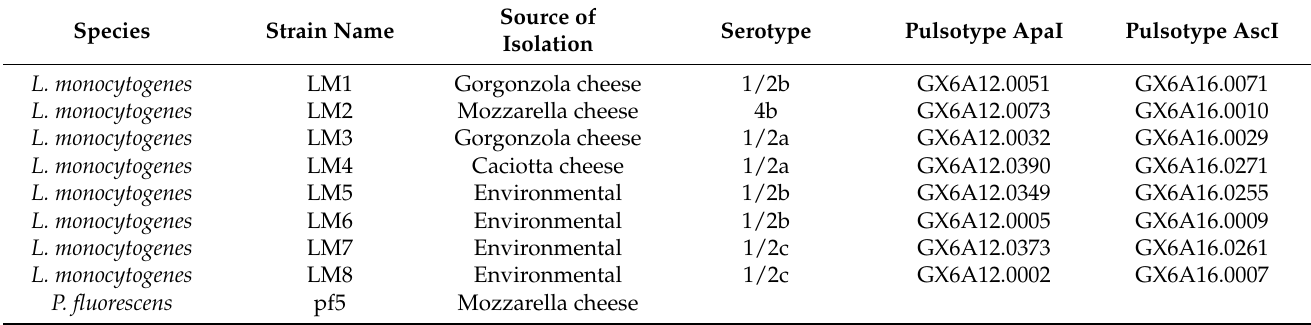
Table 1. Listeria monocytogenes and Pseudomonas fluorescens strains used in the study.